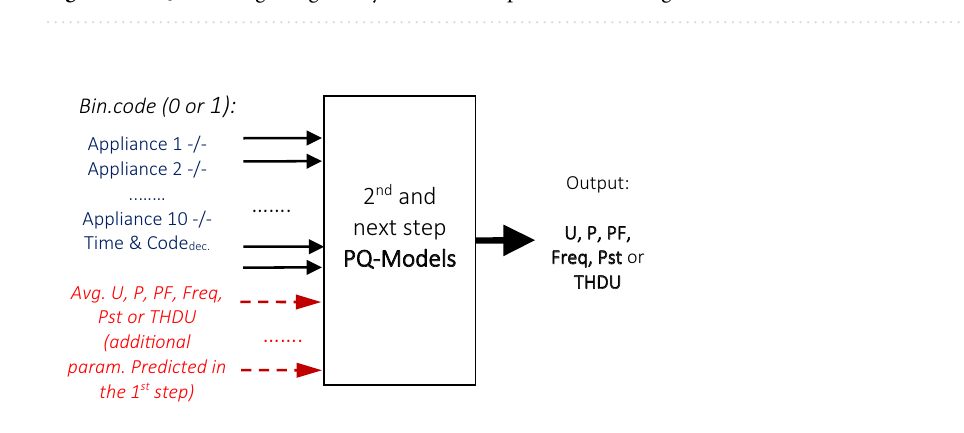
Figure 9. The input of the PQ model vector is extended by processing data of the additional PQ-correlated parameters predicted in the previous